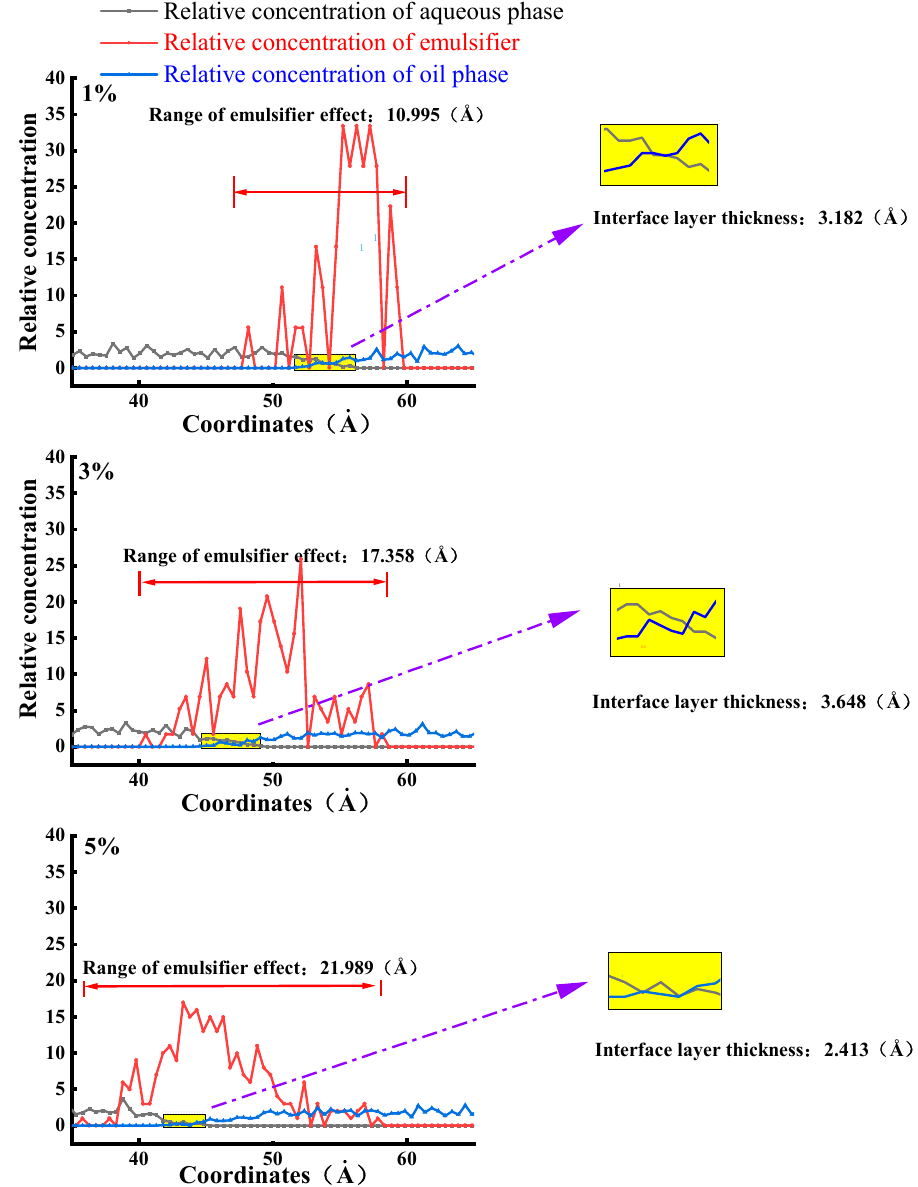
Figure 6. Concentration distribution of each component of bio-oil asphalt/water emulsion along the z -axis.